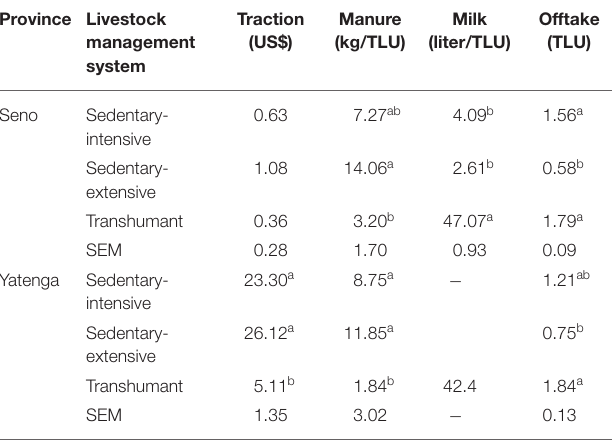
TABLE 5 | Water depleted for livestock feed per household (m 3 ha − 1 yr − 1